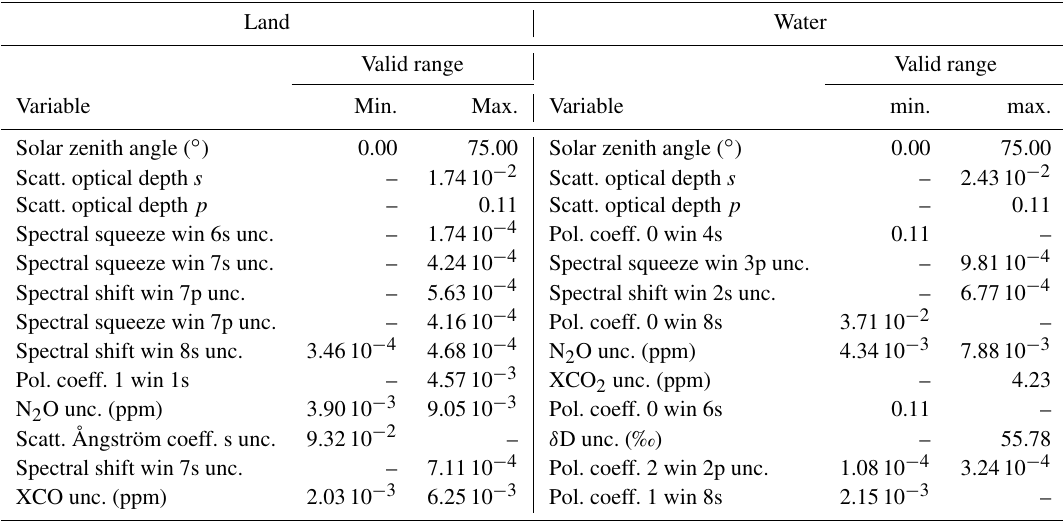
Table A12. XN 2 O filter variables and limits for GOSAT-2. “–” means that no limit is applied. Except for the solar zenith angle limits, the variables are ordered by their relevance, i.e. by the number of data filtered